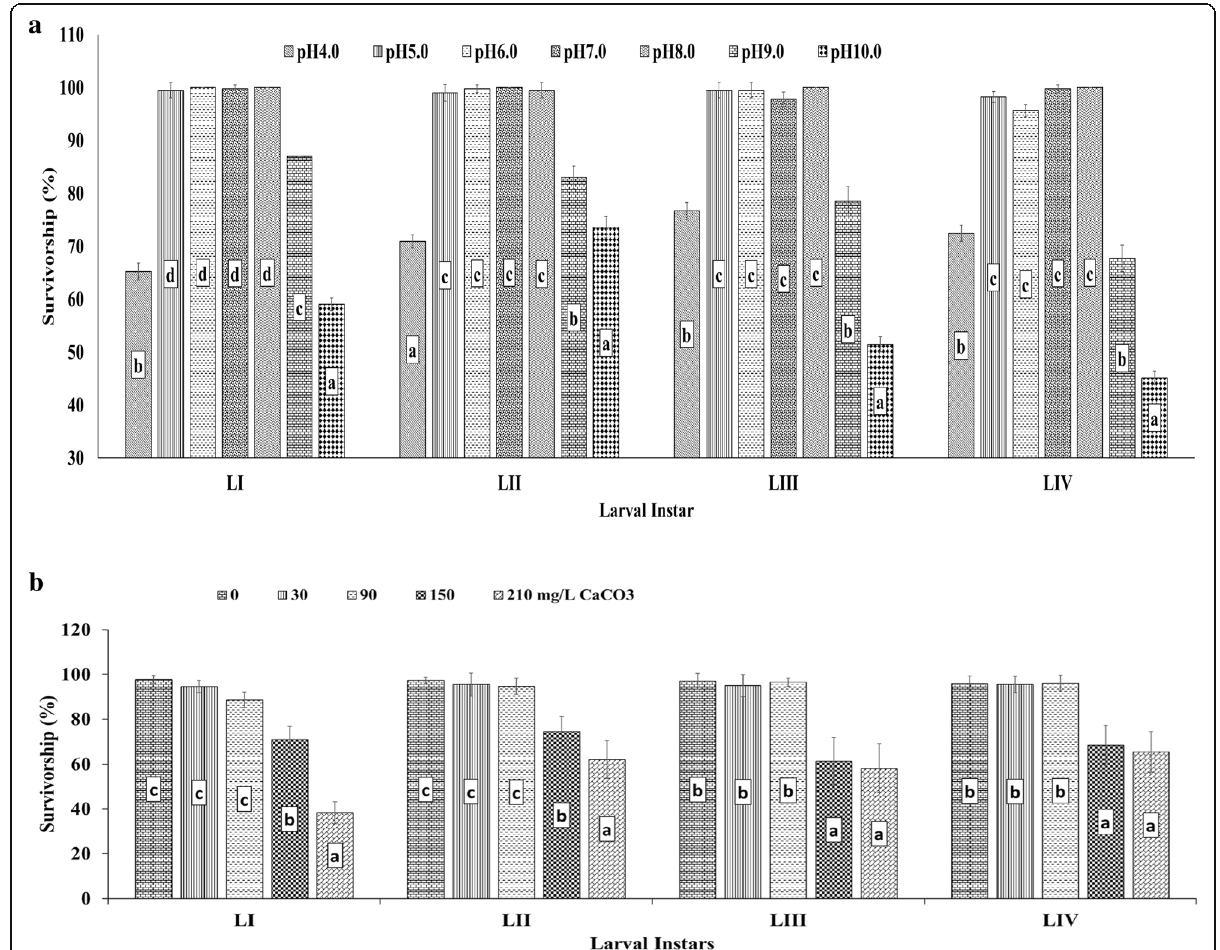
Fig. 2 Bars followed with the same letter are not significantly different at p < 0.05 according to Duncan multiple range test following ANOVA and represent mean (± SD). a Effects of water pH on daily survivorship of larval instars of Culex quinquefasciatus. b Effects of water hardness on daily survivorship of larval instars of Culex